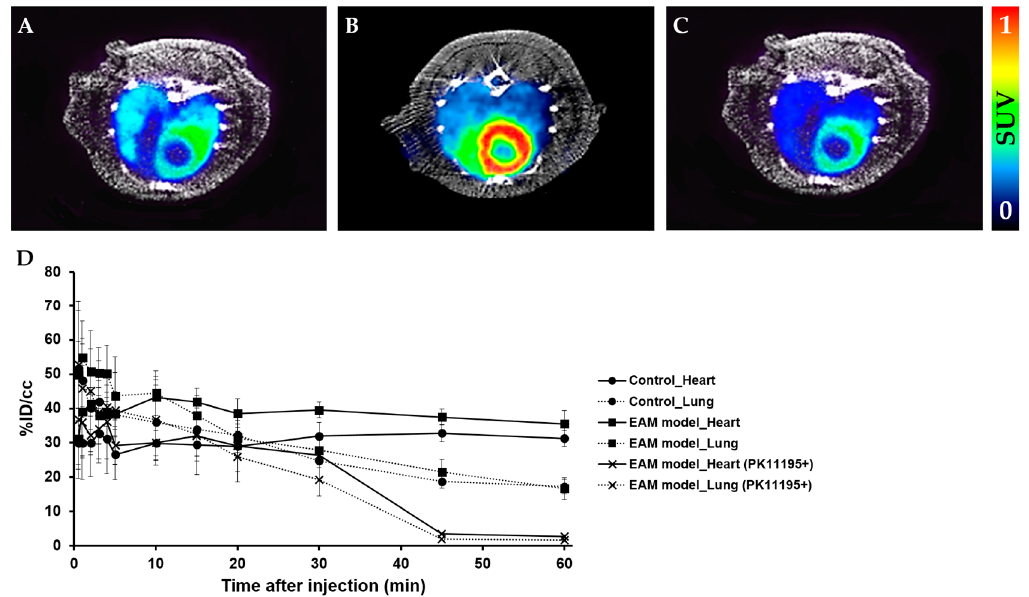
Figure 3. Representative micro positron emission tomography (microPET) axial heart images of [ 18 F] 2 in healthy rats and EAM rats at 60 min post-injection. PET images of the heart in the healthy control ( A ), EAM rat ( B ), and EAM rat after PK11195 (10 mg/kg) pre-treatment ( C ) ( n = 3). Time–activity curves of [ 18 F] 2 in the heart and lungs expressed as % ID/cc in three groups (i.e., the healthy rat, EAM rat, and EAM rat (+PK11195)) ( D ).